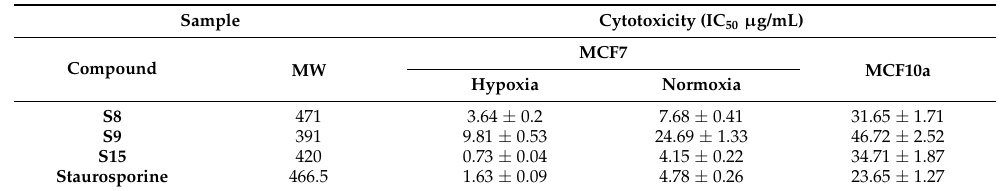
Table 3. Effect of S8 , S9 and S15 compounds on cell viability of MCF7 (normoxia and hypoxia) and MCF10a cells using Staurosporine as a reference